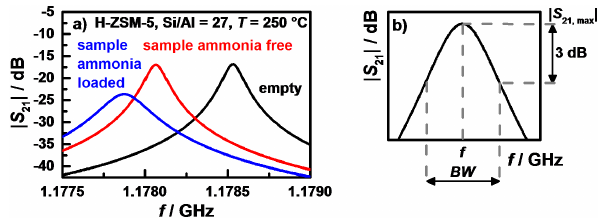
Figure 1. Example of a resonance curve of an H-ZSM-5 zeolite with Si / Al ratio of 27 at 250 ◦ C: (a) the decrease of the resonance frequency from an empty sample tube (black) over a filled one with- out ammonia loading (red) to an ammonia loaded one (blue) can be clearly evaluated. The additional increase in bandwidth by ammo- nia loading is also visible. (b) : the resonance peak in more detail, showing the resonant frequency f , 3dB bandwidth BW and maxi- mum peak height | S 21 , max | .